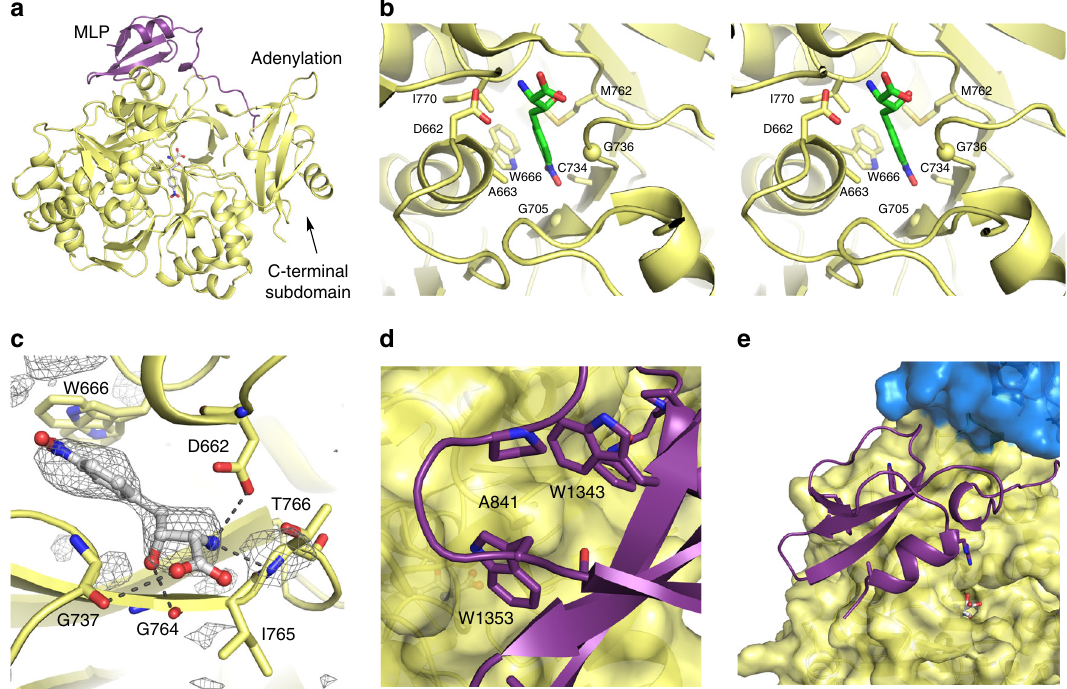
Fig. 3 ObiF1 Adenylation domain structure and MLP interaction. a The MLP domain (purple) interacts with the A domain (yellow) in the adenylate-forming conformation. b Stereorepresentation of the speci fi city determining residues of the substrate binding pocket of the adenylation domain. C α positions of two glycine residues are indicated with a sphere. Only a single conformation of the side chain of Trp666 is shown. c β -OH-p-NO 2 -homoPhe binds in the A domain active site where the β -hydroxyl forms H-bonds with backbone amide carbonyls of Gly737 and Gly764. Electron density (contoured at 2.5 σ ) calculated with mF o – DF c coef fi cients from an omit map (ligand occupancy set at zero) generated with simulated annealing. The α -amino group forms a salt-bridging interaction with Asp662 and an H-bond with the amide proton of Thr766. The side chain of Trp666, which adopts two alternate conformations, contributes to the hydrophobic pocket around the p-NO 2 -phenyl ring. d Trp1343 and Trp1353 of the MLP domain form a pocket around Ala841 of the A domain. e The MLP domain in relation to the C domain (blue) and A domain active ObiF1. Analysis of the fi nal size exclusion chromatography puri fi cation steps demonstrated that the three proteins with missing or disrupted MLP interaction were much more likely to aggregate and elute in the column void volume (Supplementary